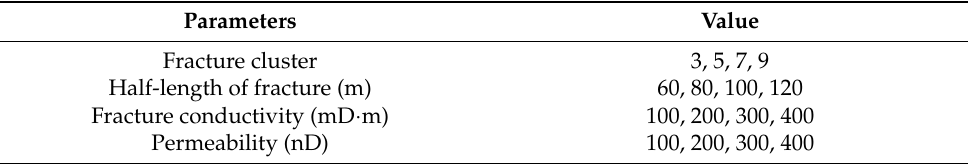
Table 1. The parameters for training data.